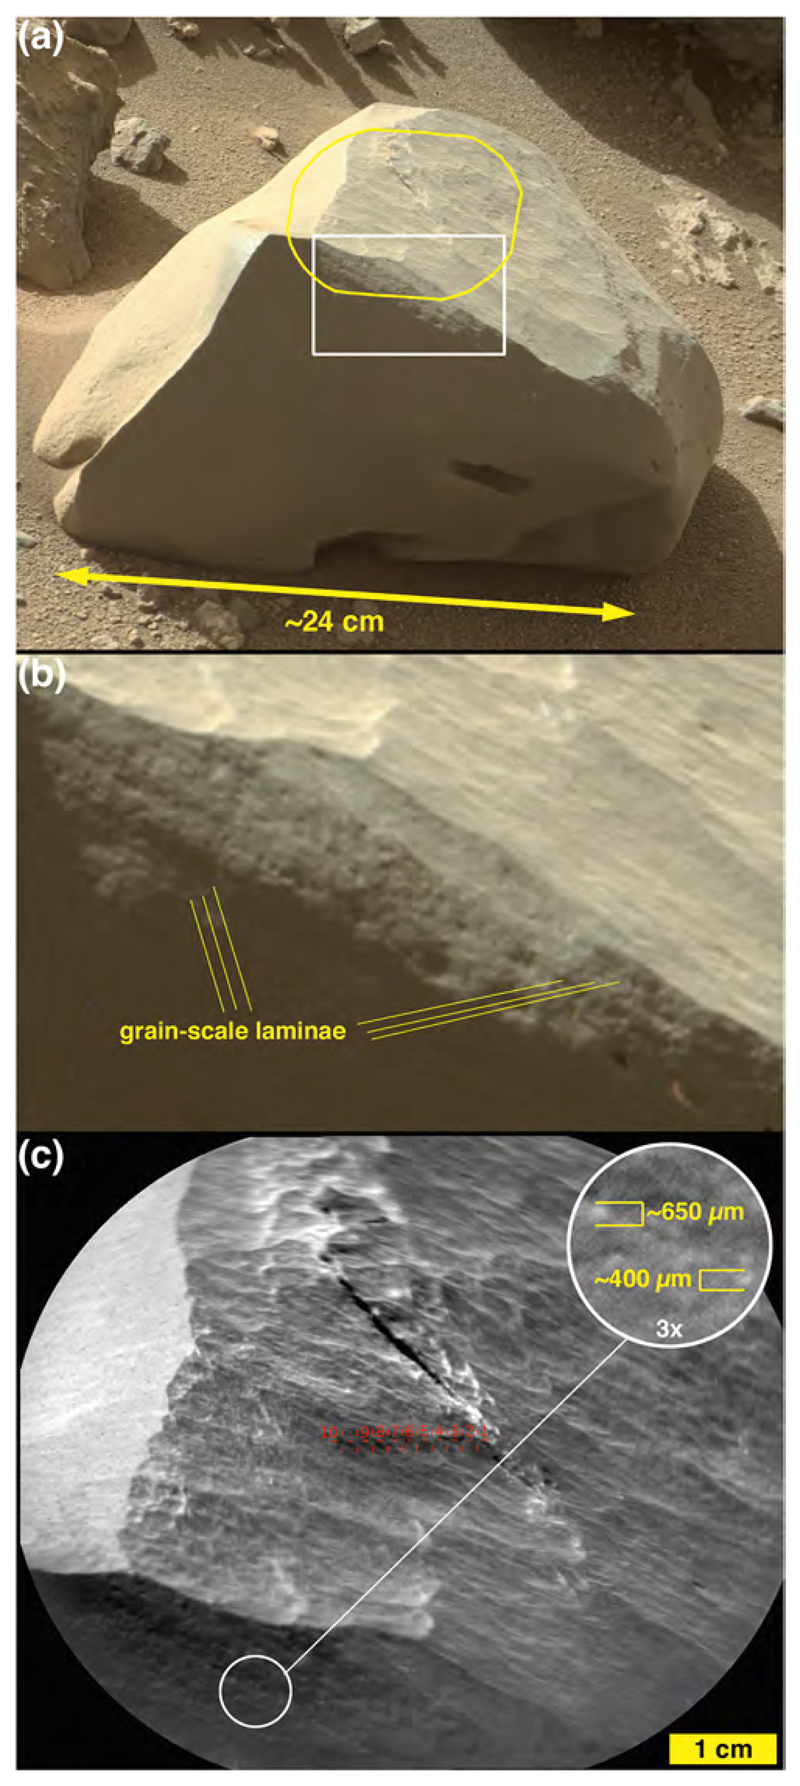
(a) Dark-gray sandstone cobble target named Oranjemund. White box indicates location of expanded view in (b); outline indicates ChemCam RMI coverage in (c). (b) View showing grain-scale bedding, which runs diagonally from upper left to lower right. (c) Close-up view of Oranjemund; inset shows 3× expanded view with measurements on features that could be among the larger sand grains in the rock (i.e., most of the grains are smaller than ~400 μm). Oranjemund is compositionally identical to layered target Chinchimane (Fig. 14).